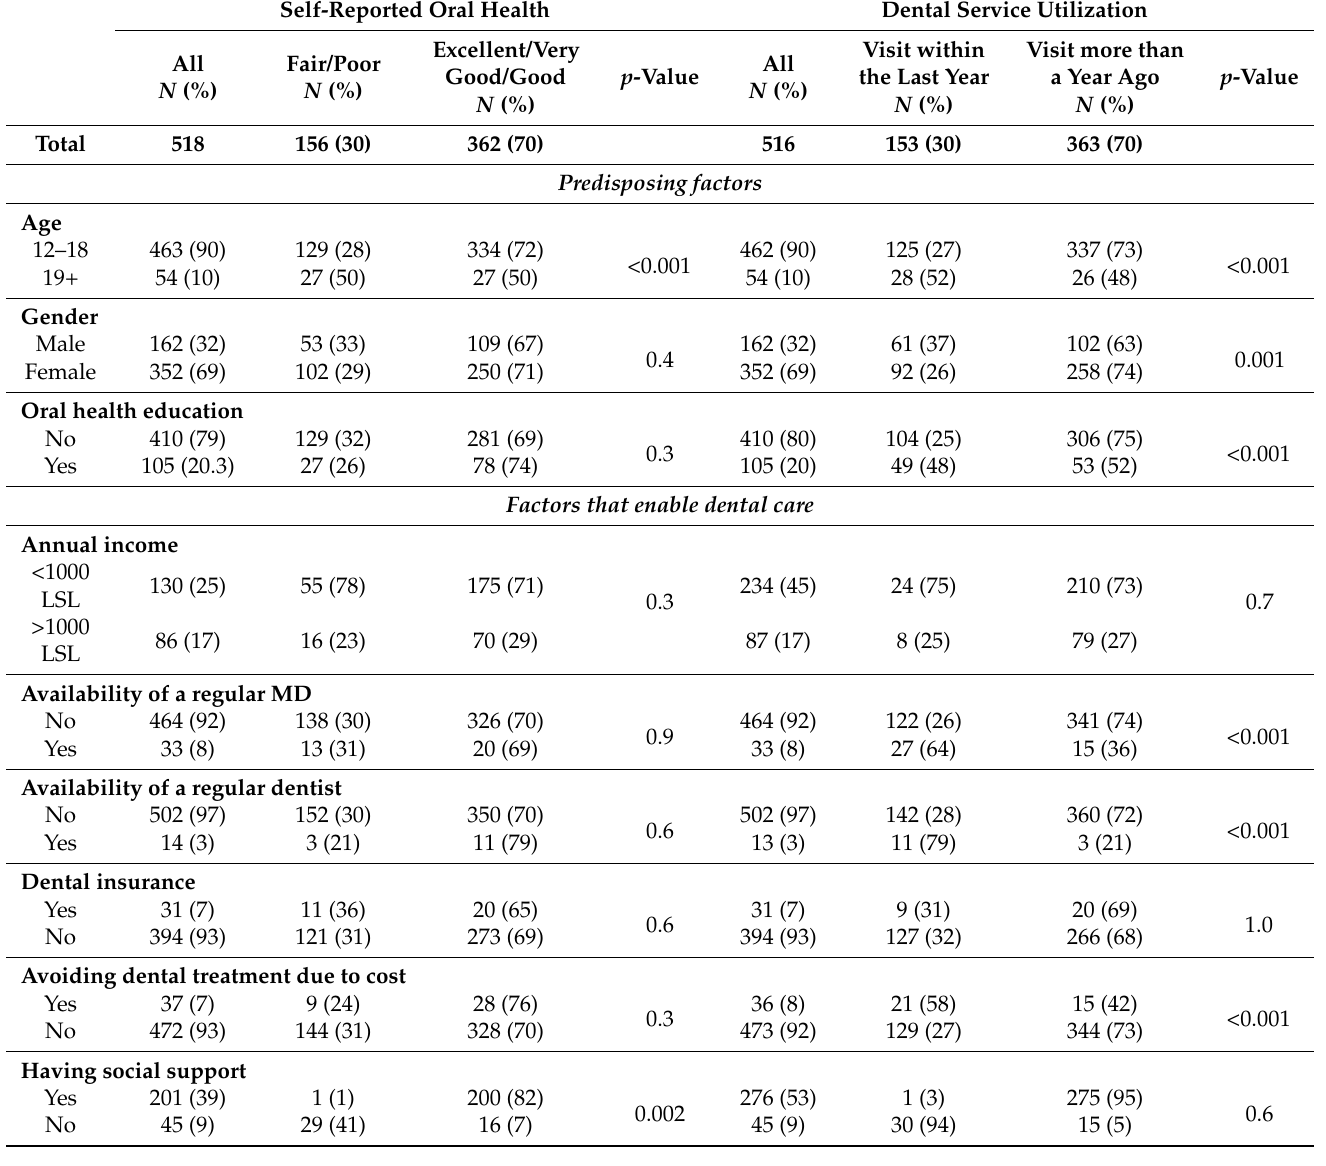
Table 3. Frequency distribution of the Andersen and Newman (A&N) predisposing and enabling factors between self- reported oral health and dental visit.